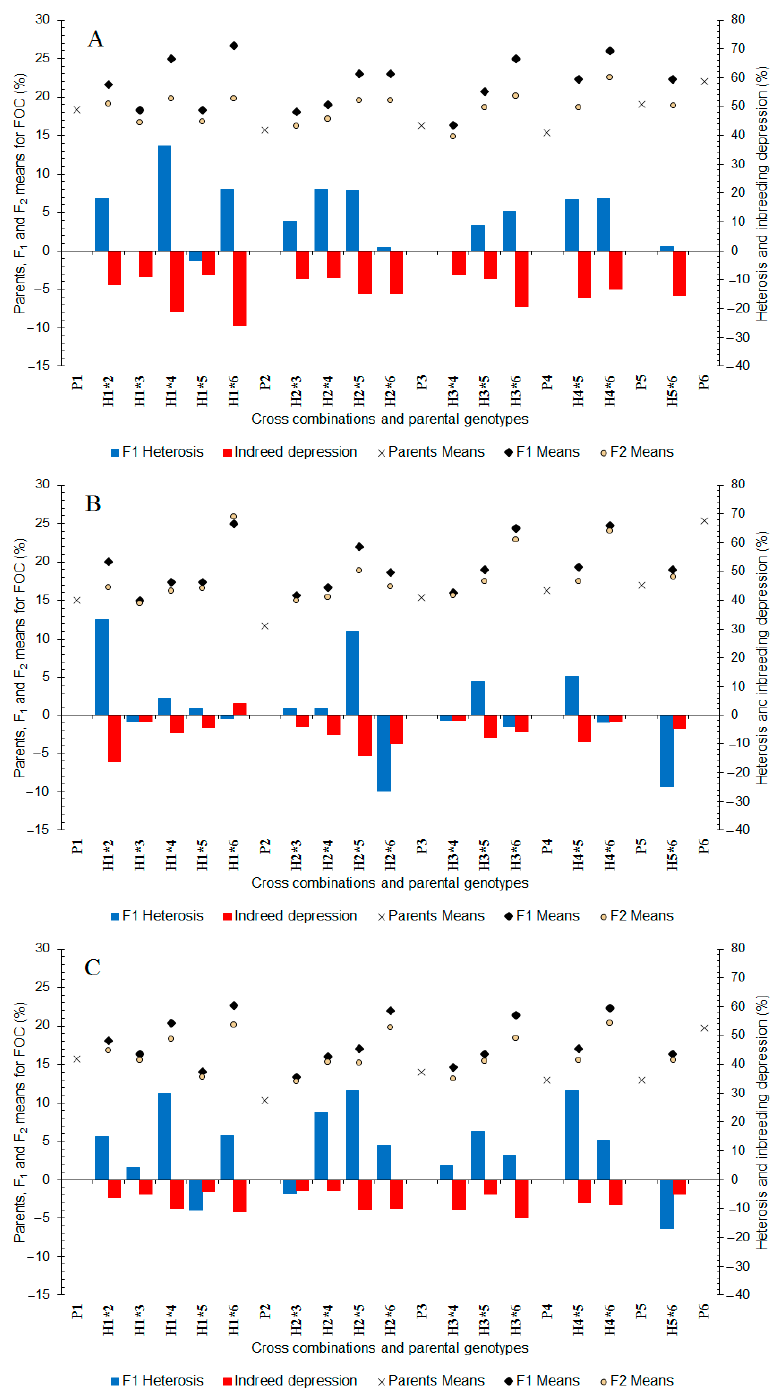
Figure 3. Mean, heterosis, and inbreeding depression for fatty oil content in F 1 and F 2 generations of coriander crosses. ( A ) Well-Watered, ( B ) Moderate Water Stress, and ( C ) Severe Water Stress. P 1 –P 6 : six parental coriander genotypes; H 1×2 –H 5×6 : 15 half-diallel hybrids.